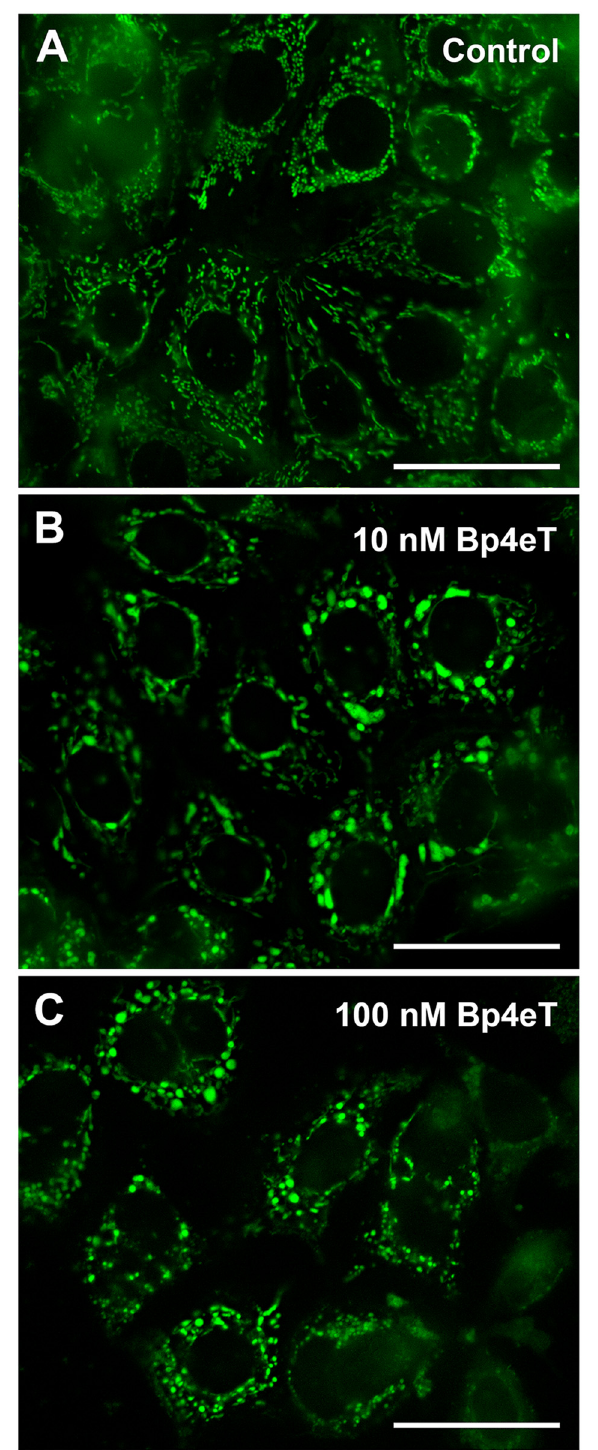
Fig 5. Bp4eT treatment causes mitochondrial swelling. MCF-7 cells were incubated for 72 h/37°C with control medium or 10 or 100 nM Bp4eT, followed by staining for 10 min/37°C with the mitochondrial probe, MitoTracker 1 Green FM. Scale bars represent 50 μ m. Results are typical of 3